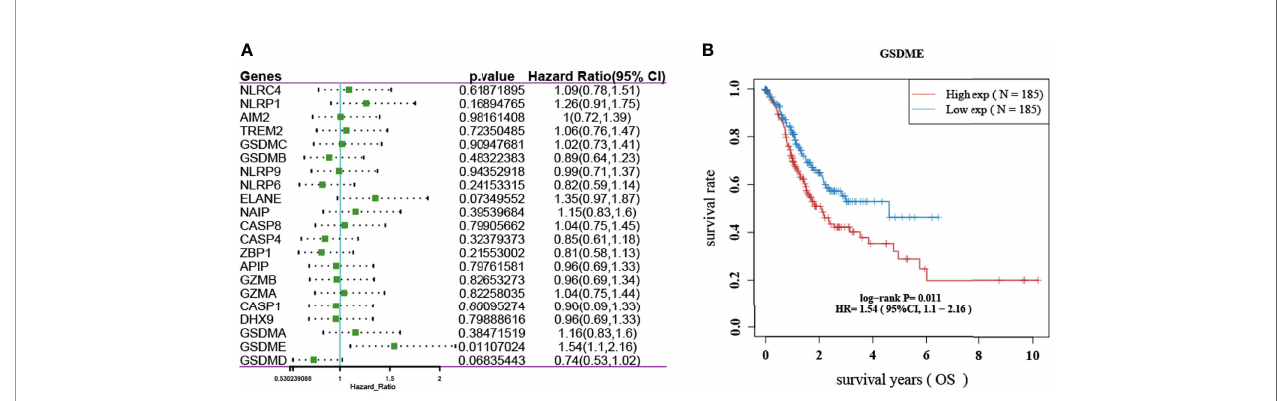
FIGURE 2 | Prognosis of pyroptosis-related genes in gastric cancer. (A) Forest plot showing the OS prognosis of pyroptosis-related genes in gastric cancer. (B) KM survival curve of GSDME in gastric cancer.